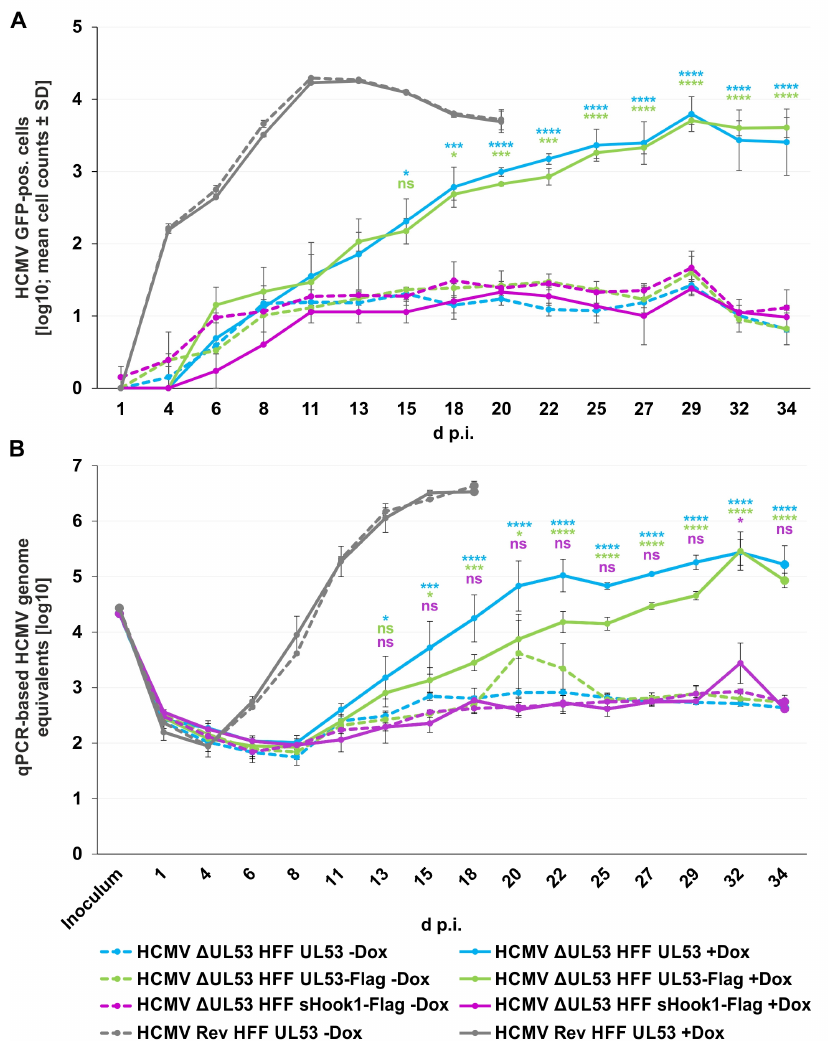
Figure 13. Viral replication kinetics of HCMV Δ UL53 and its revertant (HCMV Rev) determined by quantitation of GFP ‐ positive cells and HCMV ‐ specific qPCR on the different recombinant HFF populations. 80,000 inducibly expressing HFFs in 24 ‐ well plates were infected with HCMV Δ UL53 or HCMV Rev at a viral dose of 5 × 10 6 genome copies. pUL53, pUL53 ‐ Flag or pUL53::sHook1 ‐ Flag protein expression was either Dox ‐ induced (+Dox) or remained non ‐ induced ( − Dox). ( A ) The number of HCMV ‐ infected cells was measured by detection of GFP signal ‐ positive cells at indicated time points with the CellReporterXpress ® software using the ImageXpress ® Pico device. Values represent 25.04 % of the area of a well and are given as a mean value ± SD of two independently infected wells. ( B ) Viral supernatants were harvested at indicated time points and viral genome equivalents were determined by qPCR. Each value represents the mean ± SD of two independent biological replicates, each measured twice. ( A , B ) Statistical analysis was performed using an ordinary two ‐ way ANOVA and post ‐ hoc Sidak correction; ****, p < 0.0001; ***, p < 0.001; *, p < 0.1; ns, not significant; no significant differences were noted for values between 1–13 d p.i. ( A ) or 1–11 d p.i. ( B ), respectively. 4. Discussion With this study, we aimed to identify a common structural panherpesviral NEC scaffold that enables hook ‐ into ‐ groove interactions between NEC proteins derived from